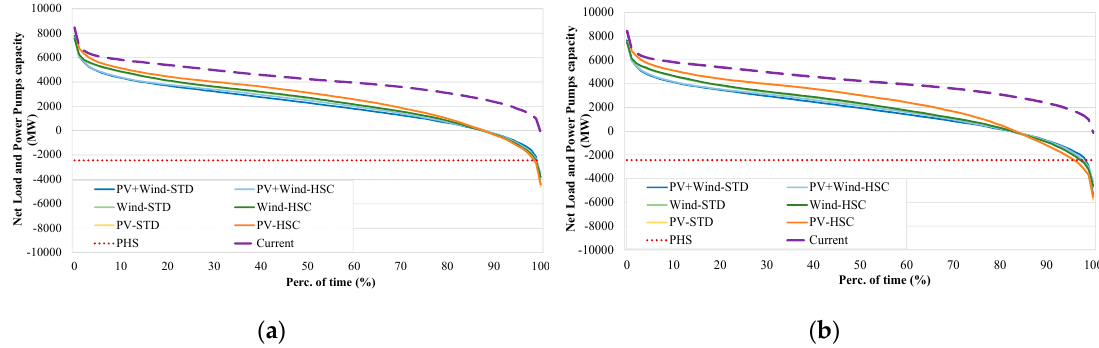
Figure 10. Net load duration curve using a Surplus